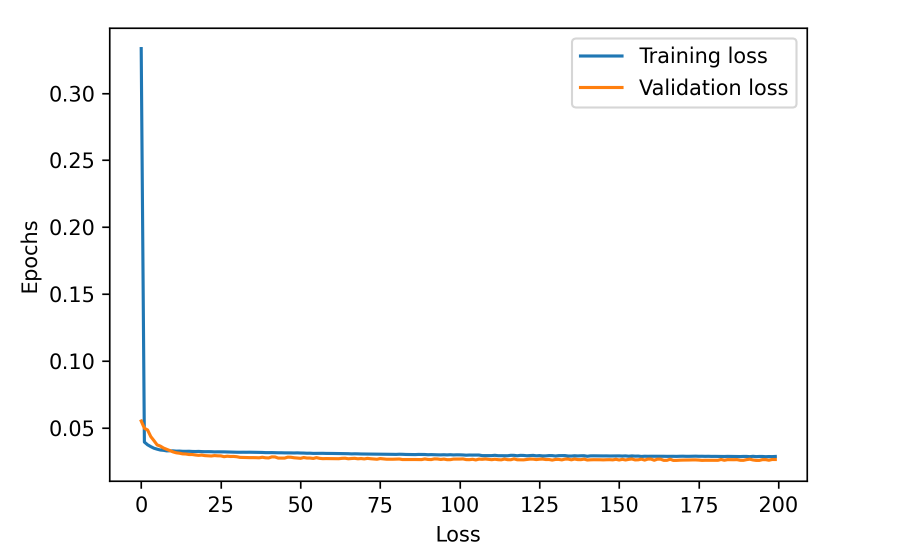
Figure A2. Training and validation losses during the training of